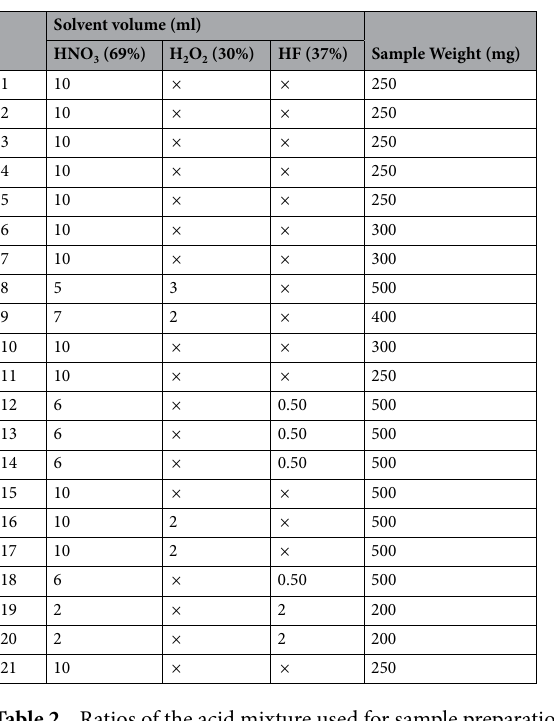
Table 2. Ratios of the acid mixture used for sample preparation for metal impurity detection.